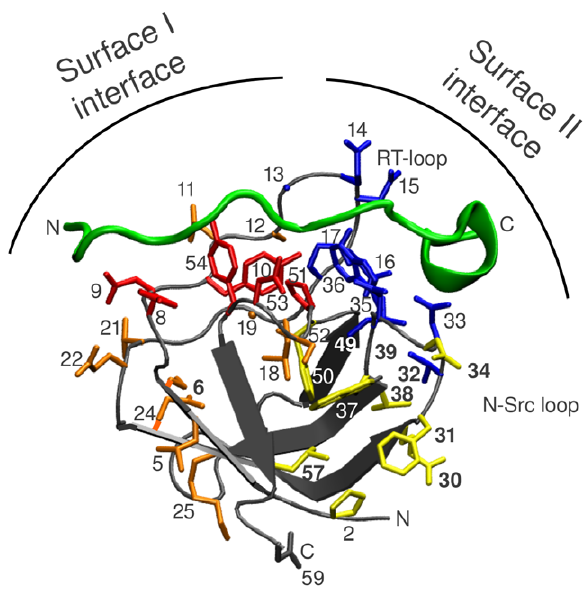
Figure 1. Structure of AbpSH3 (grey) bound to ArkA (green), emphasizing residues that undergo significant chemical shift changes on peptide binding. SI residues are colored red and residues associated with SI are colored orange (only the amide nitrogen of residue 19 is shown to avoid too much crowding). SII residues are colored blue and residues associated with SII are colored yellow. The N- and C-termini for protein and peptide are also indicated that includes the side-chain of asparagine 59 in AbpSH3. The labels for residues found to display co-linear chemical shift behavior in Fig. 2A are in bold. Chemical shift differences between peptide-free and ArkA-bound AbpSH3 can be found in Table S1.